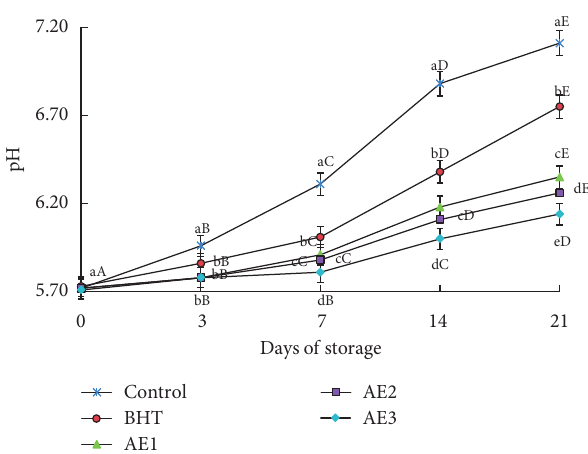
Figure 1: Effect of the aqueous pomegranate peel extract on pH of minced beef meat during storage at 4 ° C.